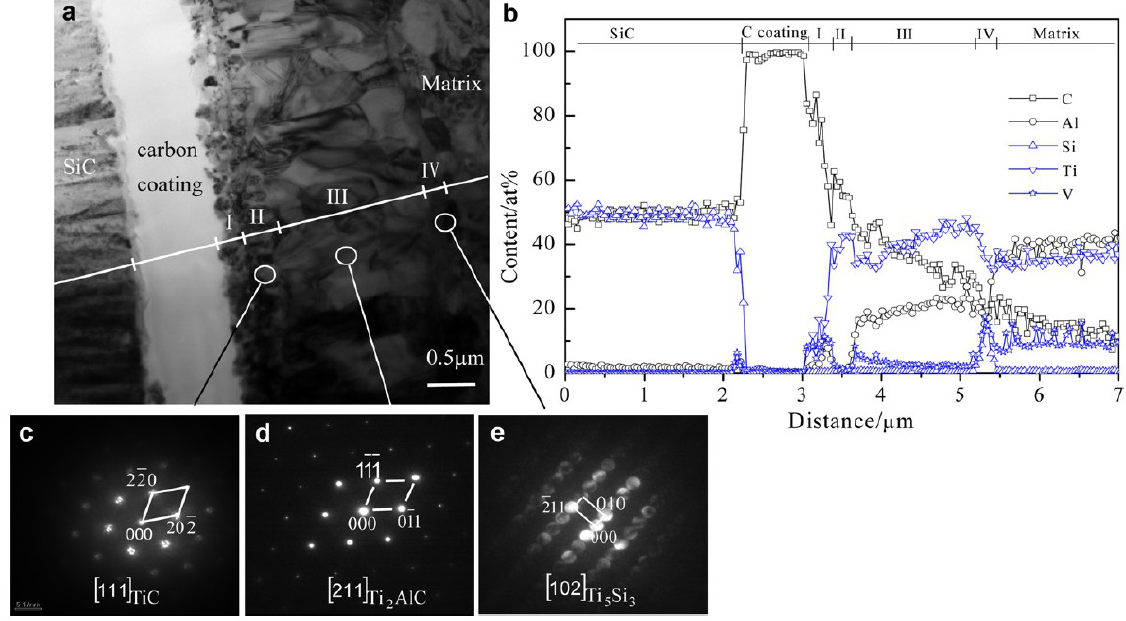
Figure 10. ( a ) TEM morphology of interfacial reaction zone between SiC fiber and TiAl matrix; ( b ) Composition distribution profile across the interfacial reaction zone and electron diffraction patterns of ( c ) TiC in layer II; ( d ) Ti layer IV. (Reprinted with permission from [96]. Copyright 2013, Elsevier.)